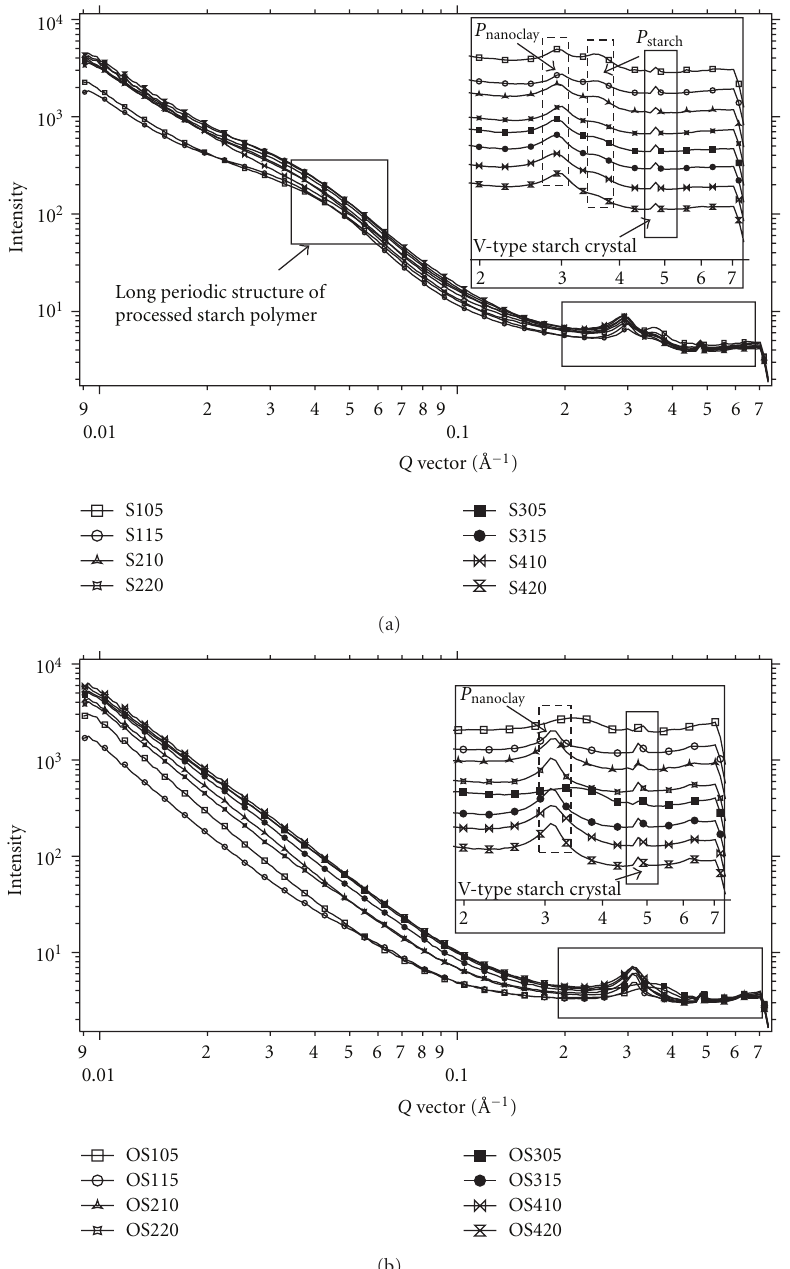
Figure 4: SAXS profiles for starch/sorbitol/nanoclay bionanocomposite samples (a) high-moisture-content and (b) low-moisture-content samples generated from NIKA data processing